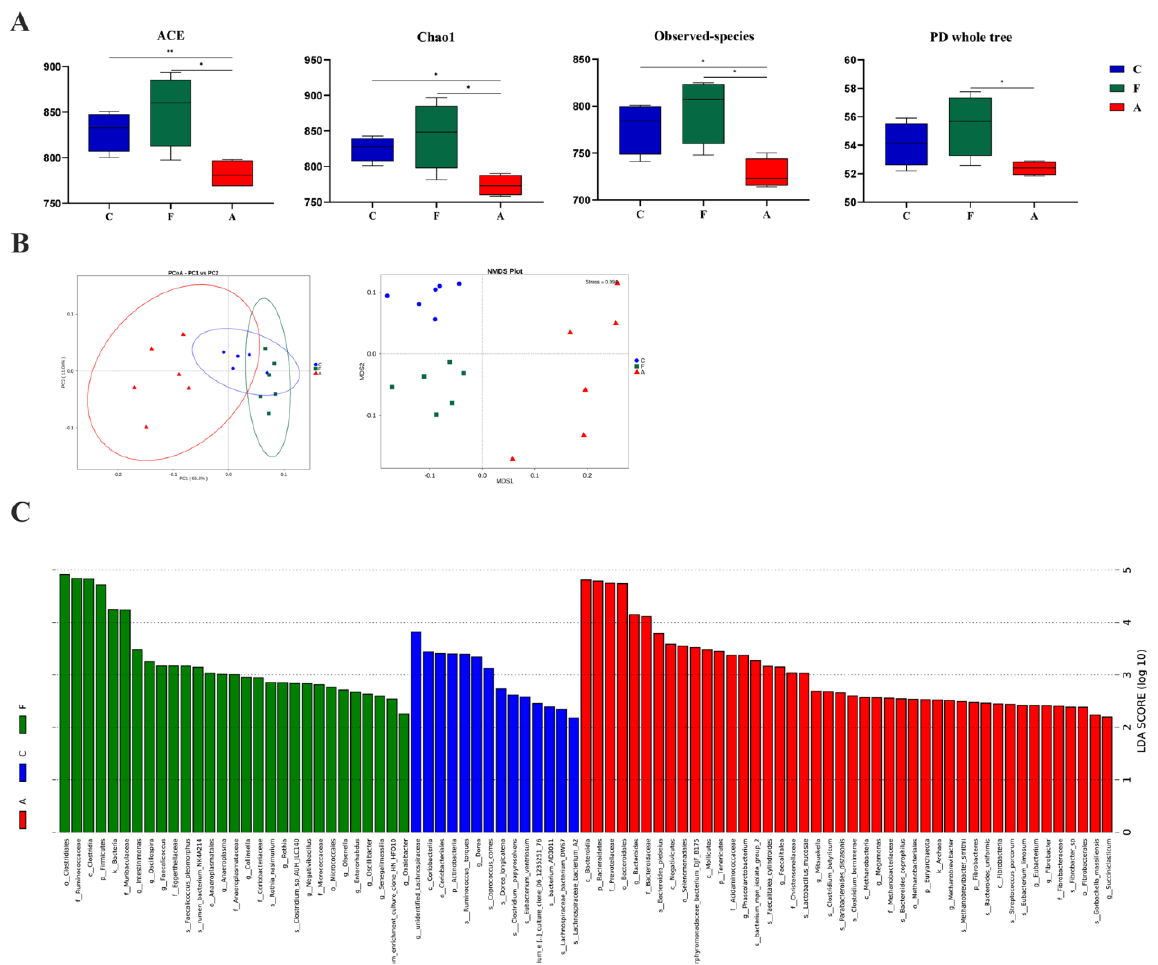
Figure 2. The diversity and structural changes of intestinal microbiota in piglets. ( A ) Alpha diversity of the microbial community estimated by observed species, Chao1, ACE, and PD whole tree in the colon. ( B ) Scatter plot of PCoA based on weighted Unifrac distance. NMDS plot of bacterial communities based on BrayCurtis distance separated the three groups. ( C ) LDA score plot of colonic microbiota with significant differences among groups were obtained from LDA Effect Size (LEfSe) analysis. Microbiota with LDA score higher than 2 were considered as biomarker microbiota (p: phylum level, c: class level, o: order level, f: family level, g: genus level). C: control group, F: FAM group, A: antibiotic group. ** p < 0.01, * p < 0.05.